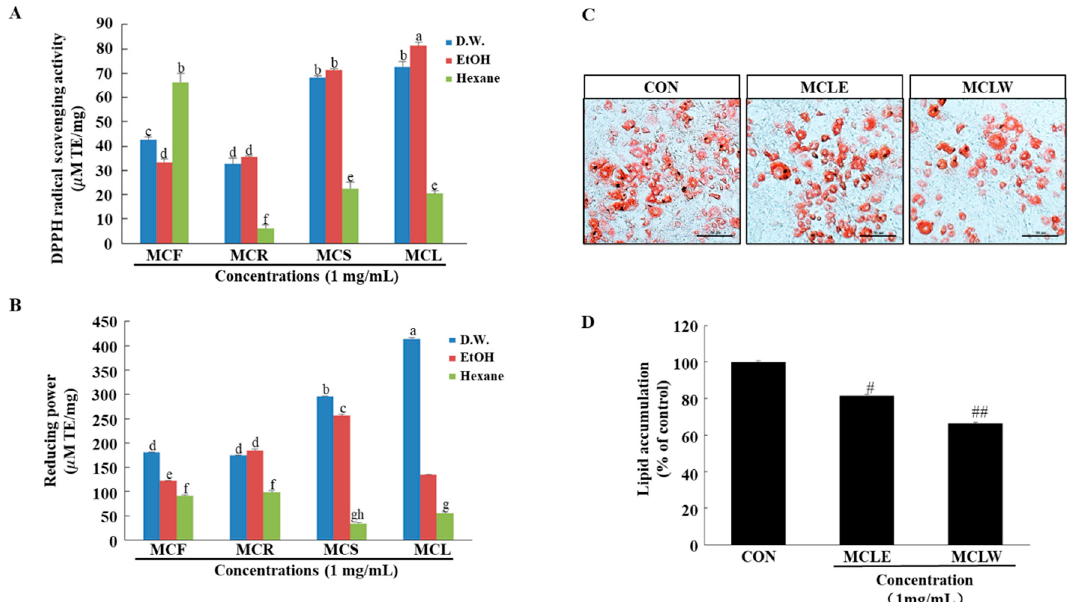
Figure 2. Effect of M. charantia on antioxidant and anti-obesity activity. DPPH radical scavenging activity ( A ). Reducing power ( B ). Lipid accumulation was measured using Oil-Red O staining. Sample-treated 3T3-L1 adipocytes ( C ), and lipid levels in 3T3-L1 adipocytes ( D ). Original magnification: 200 × . a–h Values with different superscripts are significantly differ- ent at p < 0.05 as analyzed by Dunnett’s multiple range tests. Data are mean ± SEM. n = 3 per group, # p < 0.05, ## p < 0.01 vs. the control (CON).